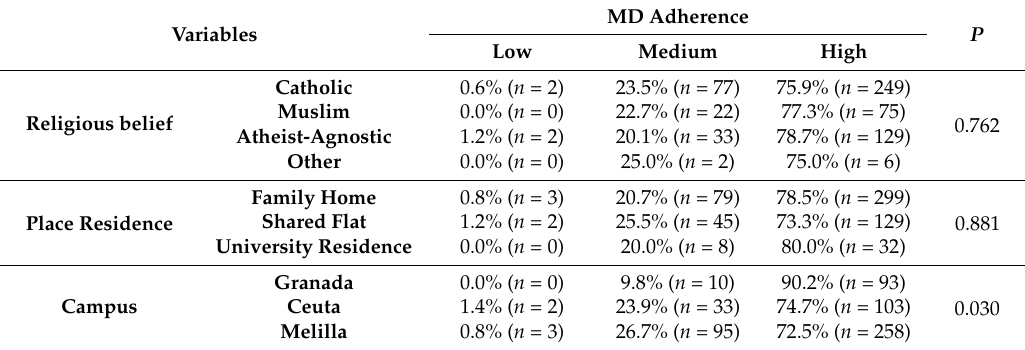
Table 5. Adherence to the MD according to religious belief, campus, and place of